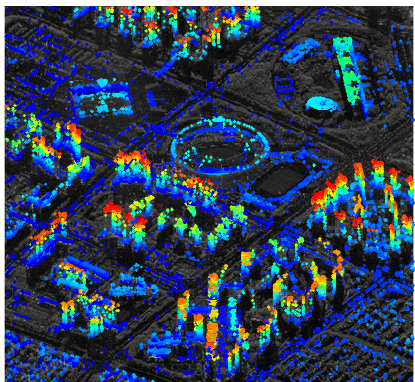
Figure 12. Estimated height visualized in mean calibrated SAR intensity image. The color bar is the same as that in Figure 11b.